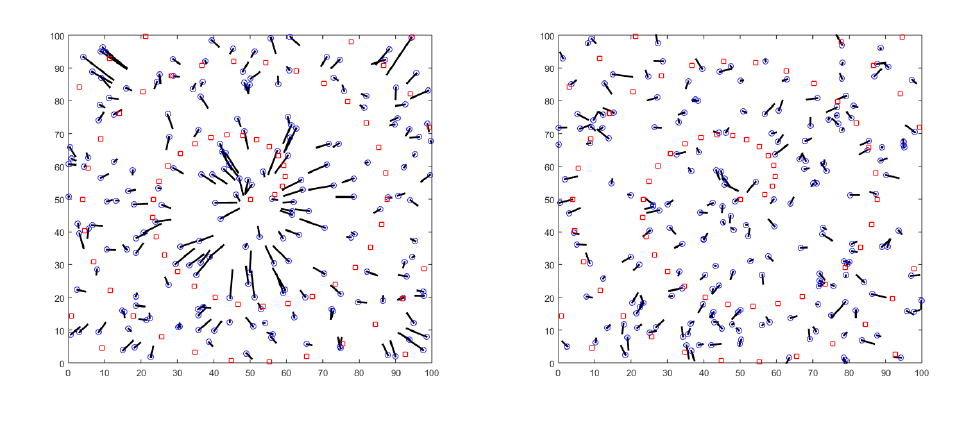
Figure 7. Localization results with spiral deployment of anchors.